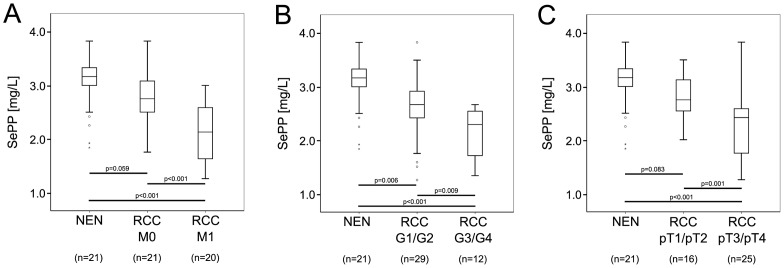
Box Plot analysis of serum SePP concentration in RCC patients and controls.RCC patients were stratified using pathologic tumor characteristics A) non metastatic versus metastatic B) G1/G2 versus G3/G4 and C) pT1/pT2 versus pT3/pT4. The corresponding significance levels between groups are given in the graph.